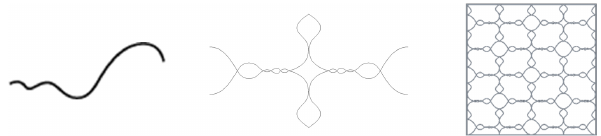
Figure 13. Evolution of the sixth